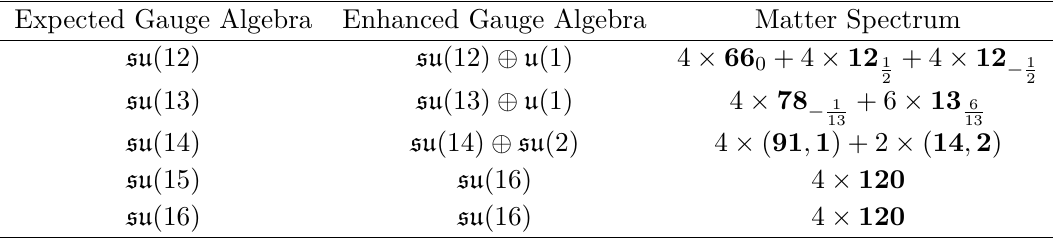
Table 2 . Automatic enhancements for T = 1 models with su ( N ) gauge algebras tuned on divisors of genus g = 0 and self-intersection b · b = 2